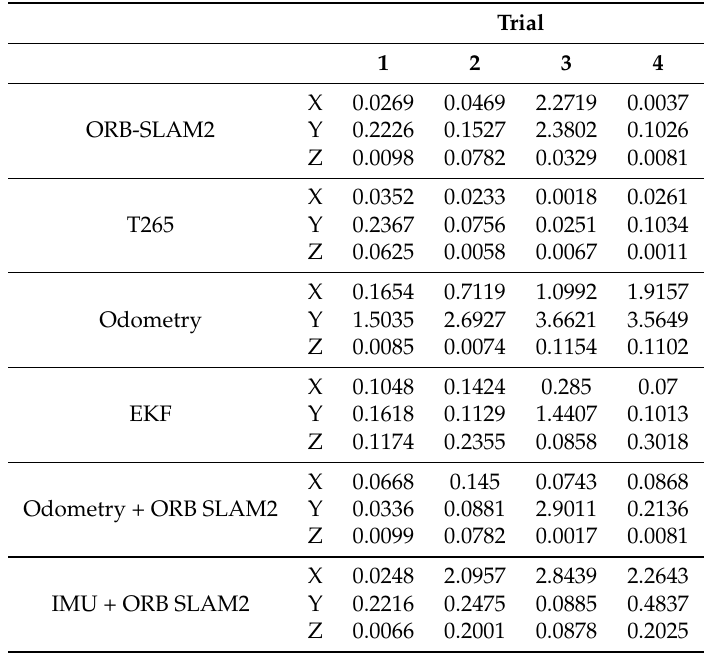
Figure 26. Indoor tests scenario 3. Trials 2–5. Error in XY position. Table 13. Final errors for the indoor scenario 2 test 3: Complete a circuit. Error Table 12. Configuration parameters for the indoor circuit test.